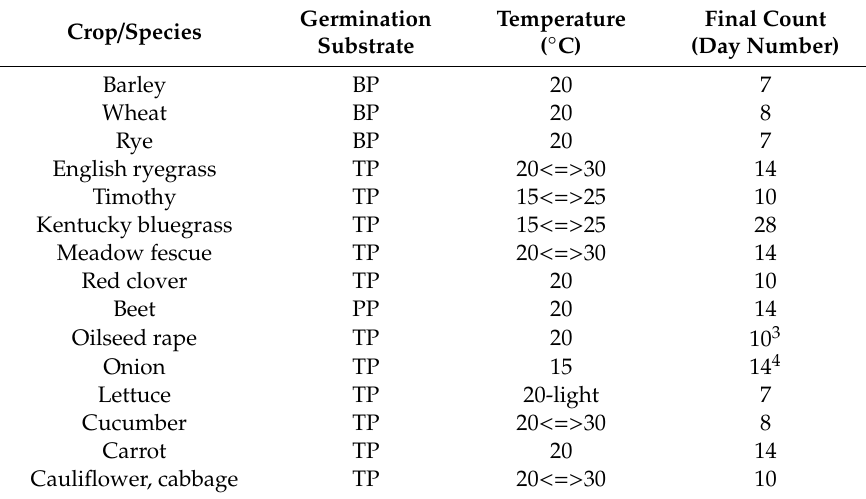
Table 5. Germination conditions for the di ff erent crops included in the experiment. Crop /